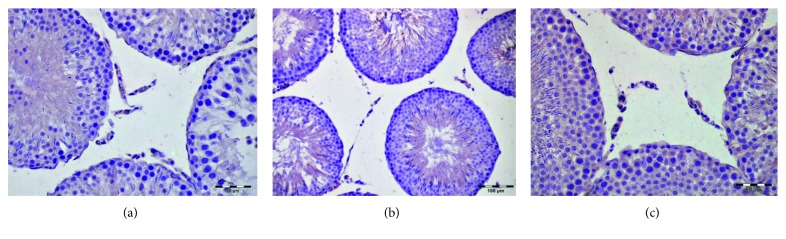
No (a) 3βHSD, (b) INSL3, and (c) GPRC6A immunoreactivity was observed in the testicular tissue sections of the subjects sacrificed on the 4th day after EDS injection. Bar = 50 μm.